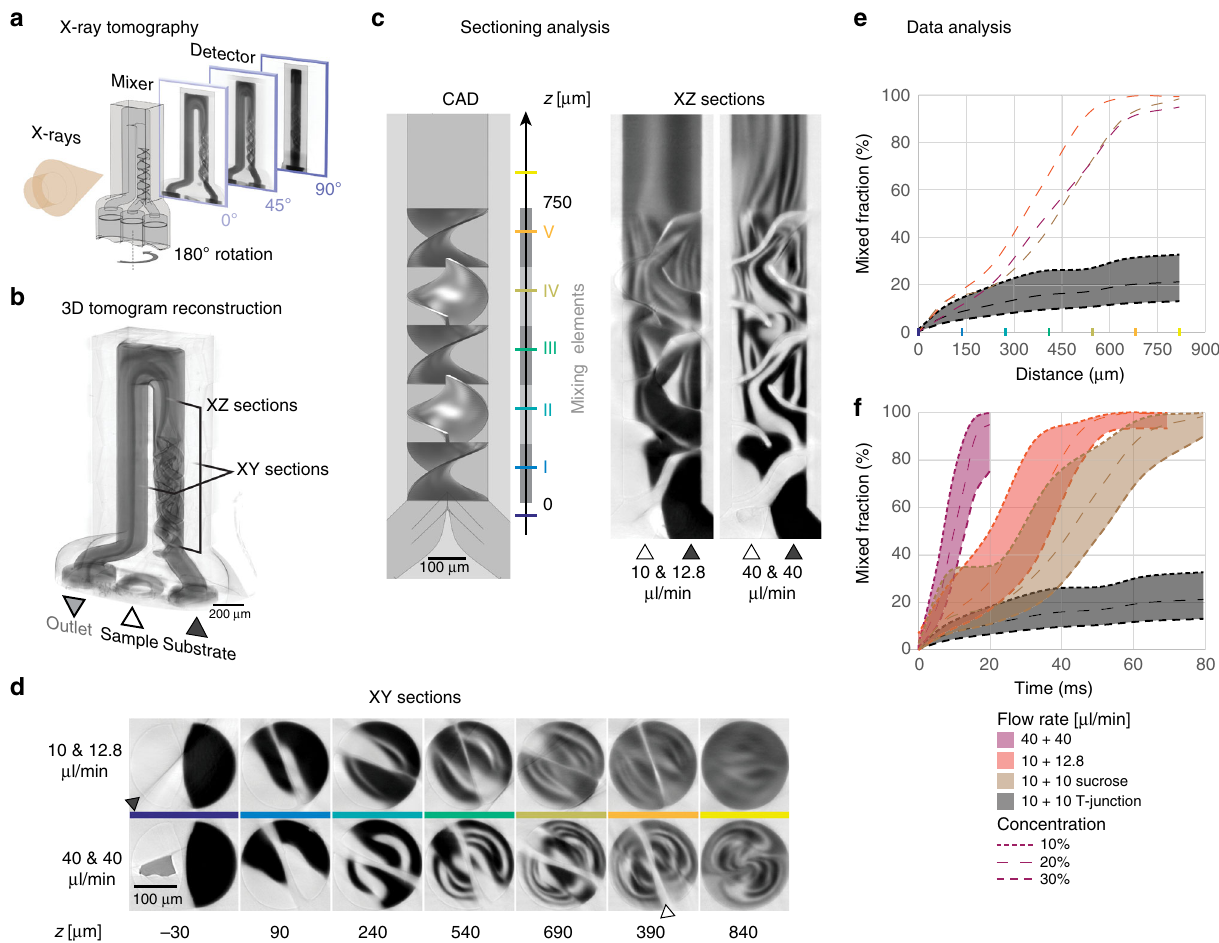
Fig. 5 Static 3D mixers for time-resolved SFX. a In X-ray microtomography a 180° X-ray projection image series is recorded while potassium iodide contrast agent is fl owing through the 3D-printed micromixer at a constant fl ow rate. b This radiograph series is then reconstructed into a 3D X-ray tomogram with 1.14 μ m edge length voxels. By sectioning the 3D tomogram volume into c vertical XZ slices and d horizontal XY slices liquid fl ow and mixing through the fi ve mixing elements highlighted in the CAD drawing can be extracted. Cross sections upstream, downstream and inside every mixing element are compared for two different liquid fl ow rate combinations. The black color represents the highly absorbing contrast agent (KI aqueous solution) and white is low absorbing water. As both liquids progress through the mixing elements they intermix into an intermittent gray level downstream (Supplementary Movies 7 and 8). The shade of gray directly represents the relative concentration of KI. The plastic material of the channel wall also appears as white. The mixing blades can be seen as straight lines cutting through circular channel cross-section (white pointer at z = 390 µ m). Reconstruction artefacts can appear as dark shadows (black pointer at z = – 30). e Mixing was quanti fi ed by analyzing pixel intensity distributions for each cross-section (Supplementary Fig. 13). The mixed fraction was insensitive of distance traveled across the mixer for three different fl ow conditions tested when compared to a matching T-junction without helical blades (see Supplementary Fig. 13D for 10 and 30% concentration envelopes). f Converting traveled distance into residence time based on the measured fl ow rate revealed the same design to be able to produce mixing timepoints between ~10 and ~50